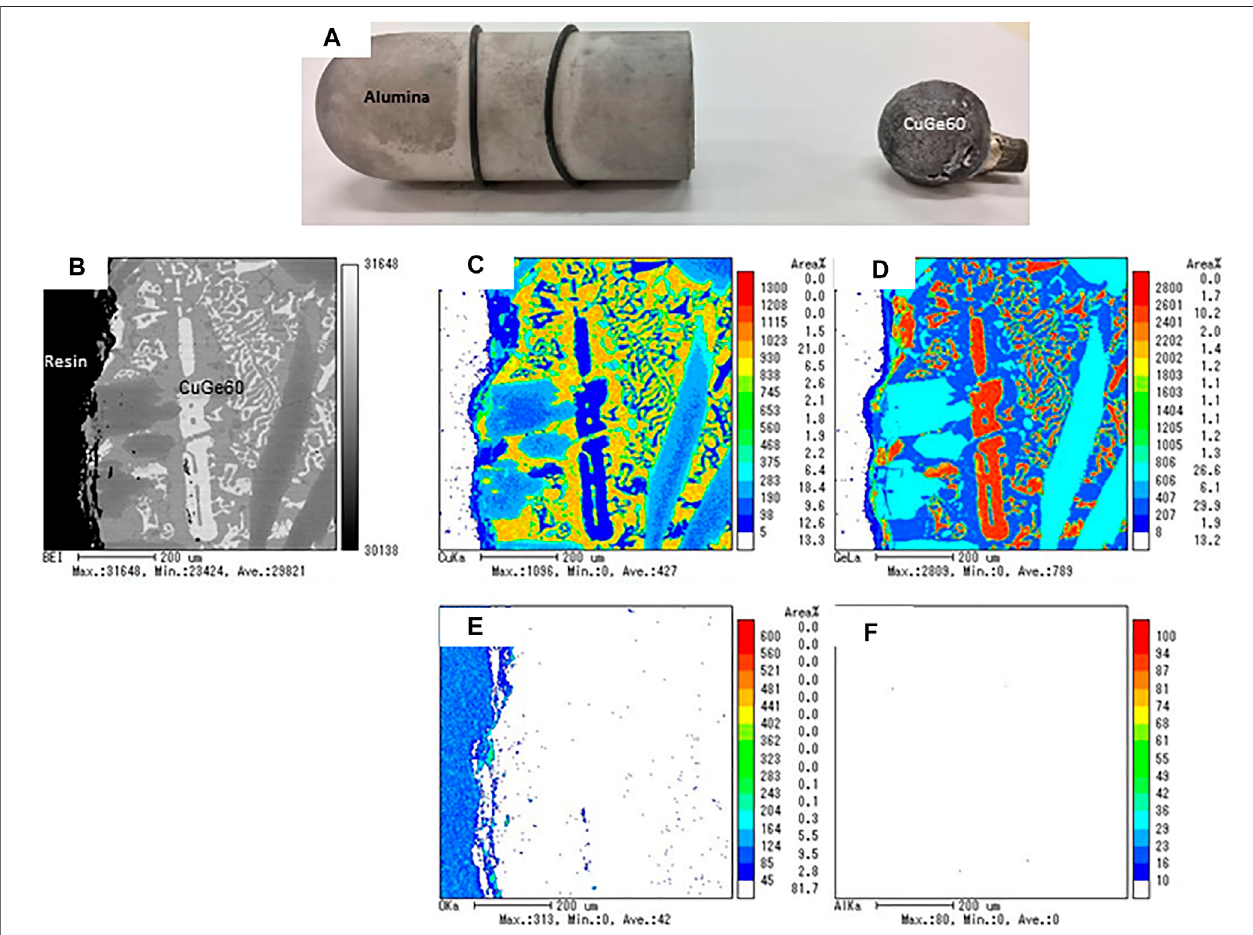
FIGURE 11 | The results of the EPMA analysis for the chemical compatibility test of alumina/CuGe60. (A) photograph of alumina tube and test sample, (B) BEI image, (C) Cu, (D) Ge, (E) O, and (F) Al mapping images.